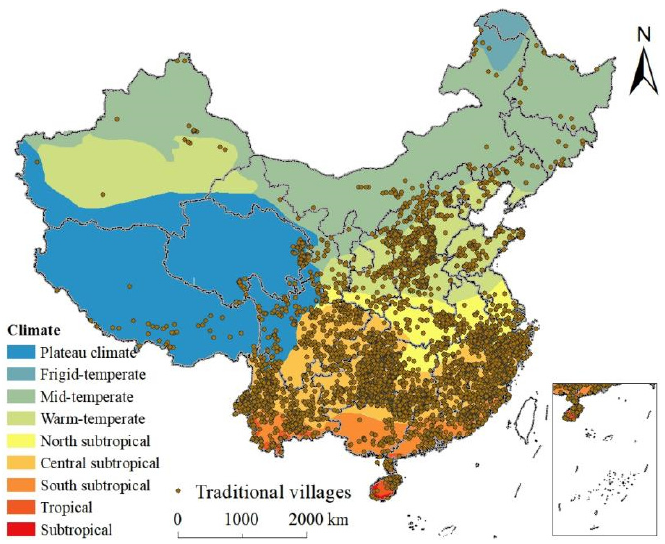
Figure 11. Spatial relationships between the distribution of traditional villages and climate.